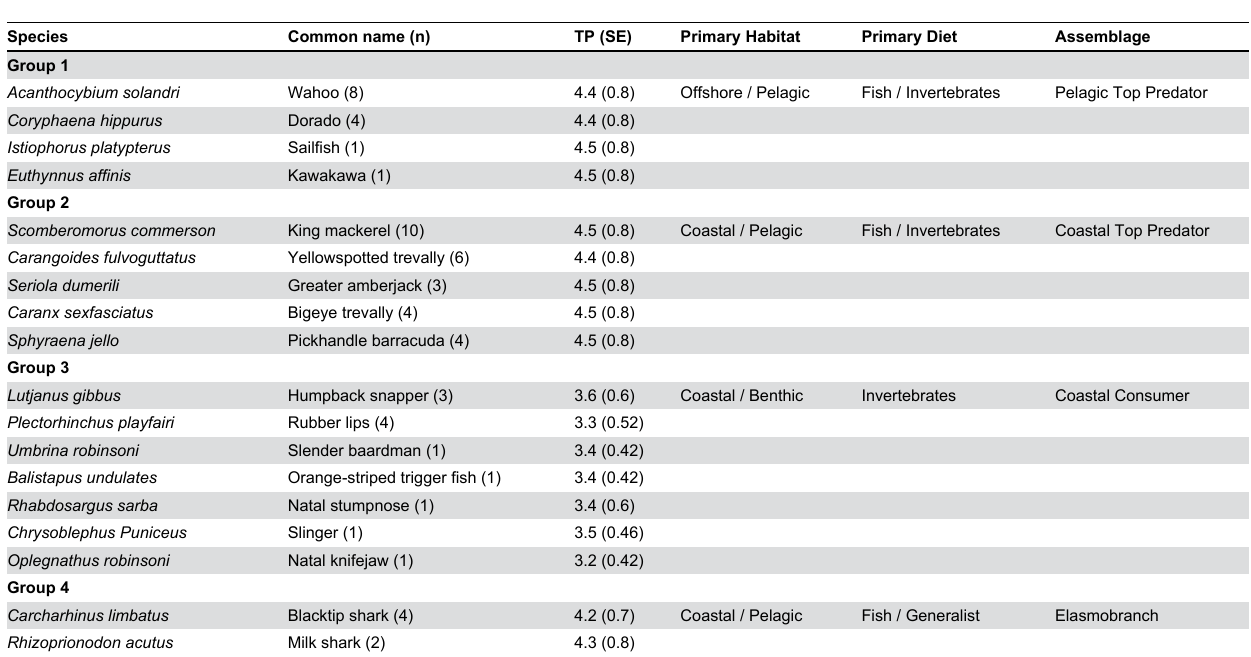
Table 1. Sampled teleost fish and shark species assigned to four groups based on their primary habitat, primary dietary items and trophic position (TP) based on stomach content established from